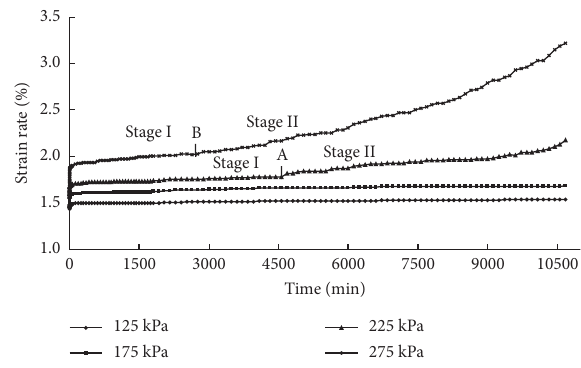
Figure 8: Creep curves of loess samples. Stage I: decay creep stage and stable creep stage. Stage II: accelerated creep stage.